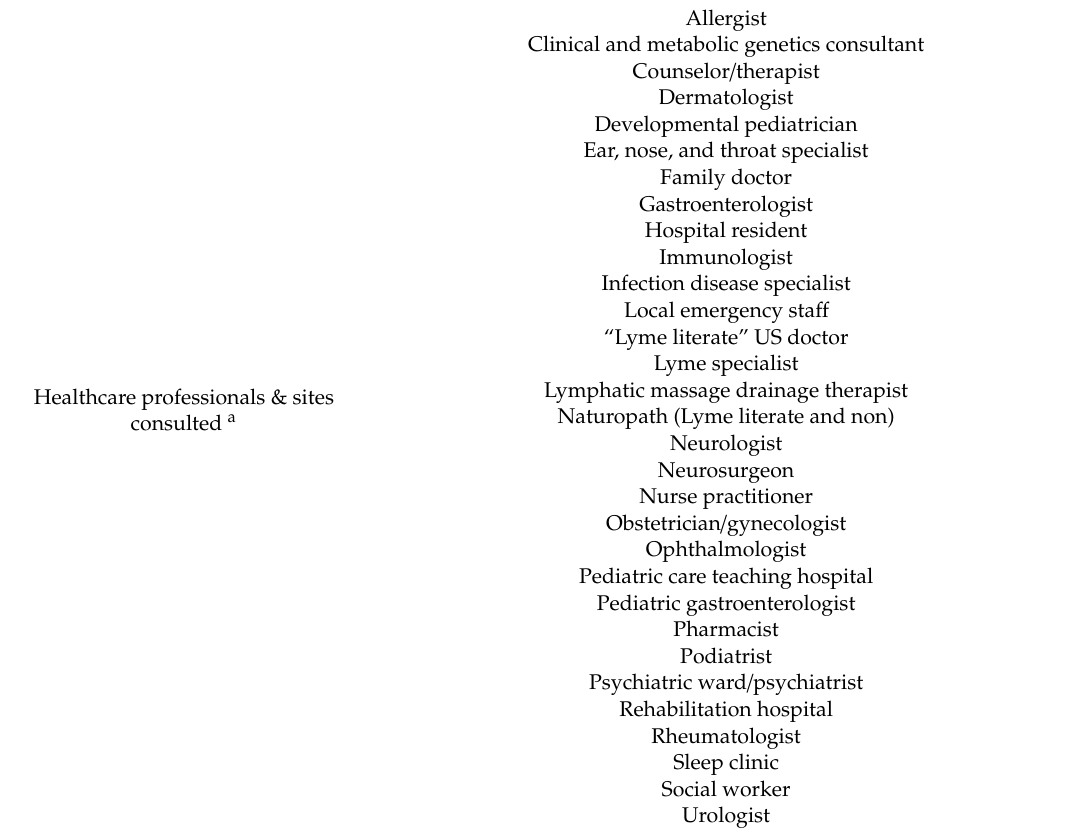
Table 3. Use of the health care